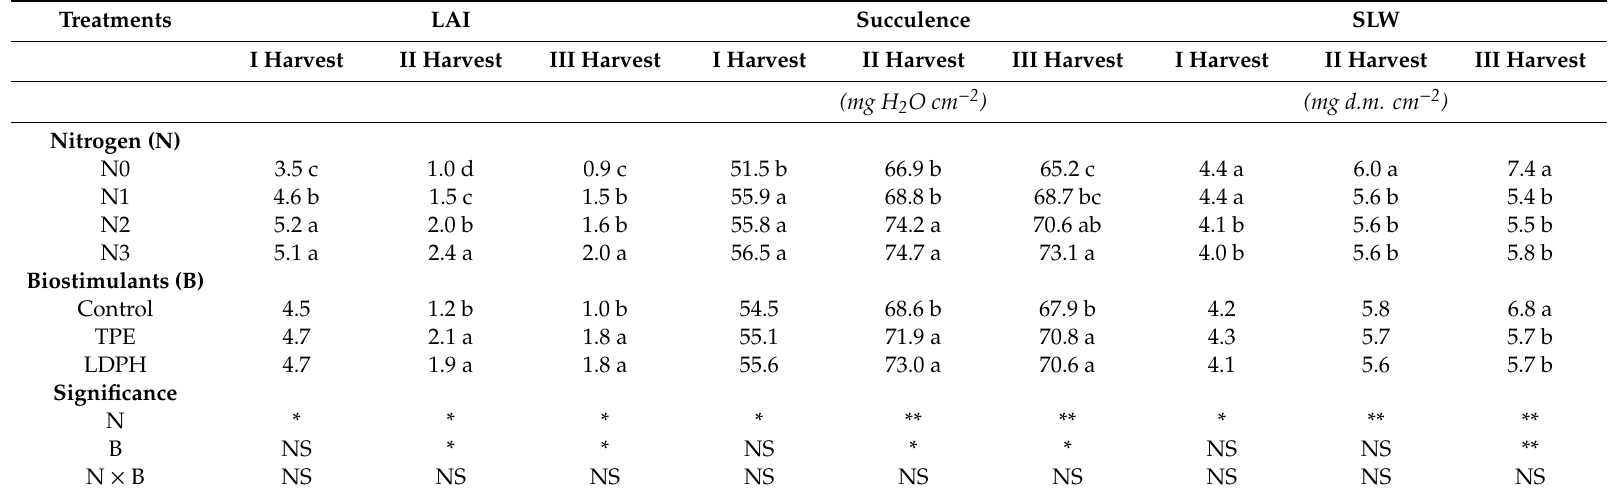
Table 2. Baby rocket leaf plant growth parameters (leaf area index (LAI), leaf succulence and specific leaf weight (SLW)) at di ff erent harvest dates in relation to N fertilization rates (N0 = 0, N1 = 60, N2 = 80, and N3 = 100 kg ha − 1 ) and biostimulant application (Control, tropical plant extract (TPE): Auxym and legume-derived protein hydrolysate (LDPH):